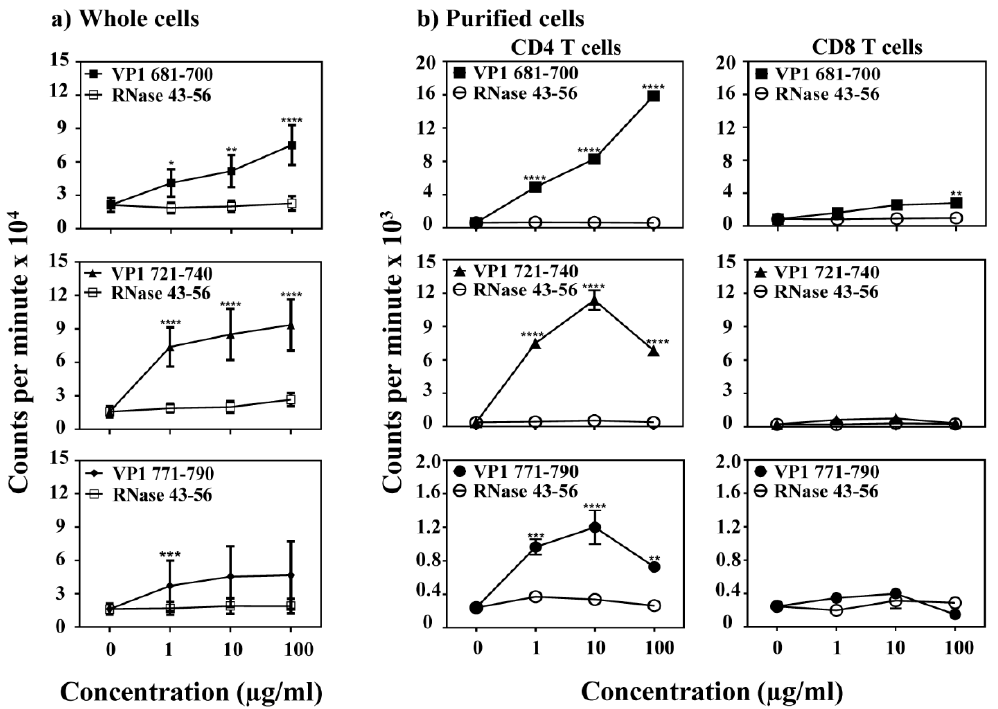
Figure 2. Determination of T cell responses in animals immunized with VP1 peptides. ( a ) Whole cells. LNCs and splenocytes obtained from mice immunized with VP1 681–700, VP1 721–740 and VP1 771–790 were stimulated with or without indicated VP1 peptides or control (RNase 43–56) for 2 days, and after pulsing with 3 [H] thymidine for 16 h, proliferative responses were measured as cpm. Representative data set obtained from five individual experiments each involving three to five mice are shown. ( b ) Purified cells. LNCs obtained from mice immunized with VP1 681–700, VP1 721–740 and VP1 771–790, and CD4 and CD8 T cells were enriched using negative selection by magnetic separation. Purified cells were stimulated with the irradiated antigen presenting cells (APCs) / peptides for 2 days. After pulsing with 3 [H] thymidine for 16 h, proliferative responses were measured as cpm. Representative data set from two individual experiments each involving three to five mice is shown. * p ≤ 0.05, ** p ≤ 0.01, *** p ≤ 0.001, and **** p ≤ 0.0001.